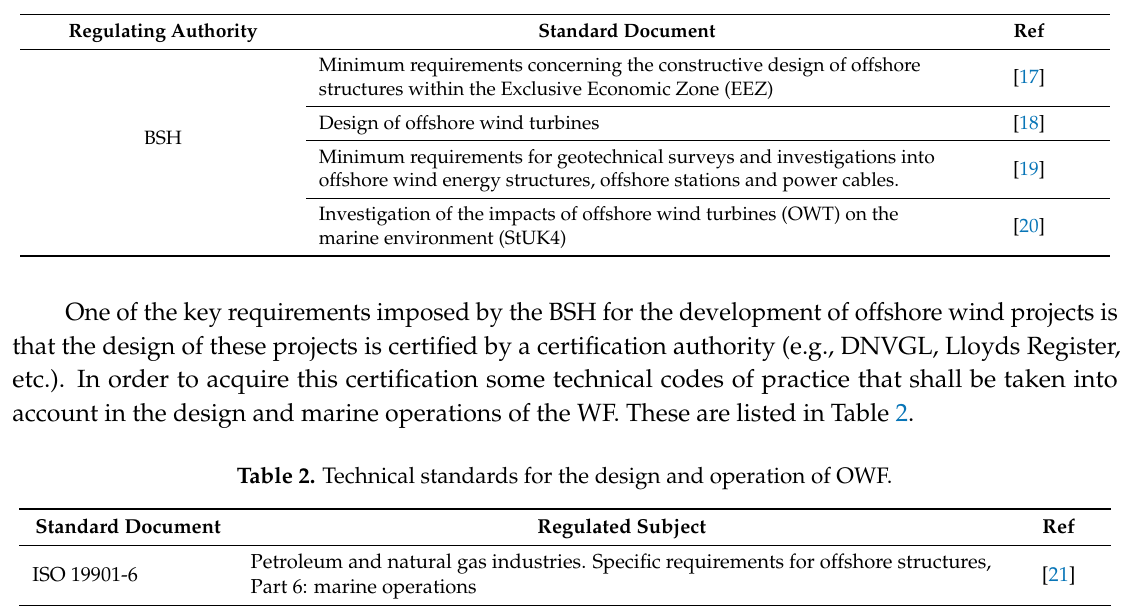
Table 1. Bundesamt für Seeschifffahrt und Hydrographie (BSH) regulations to be abided for the development and operation of offshore wind farms (OWF) in Germany.